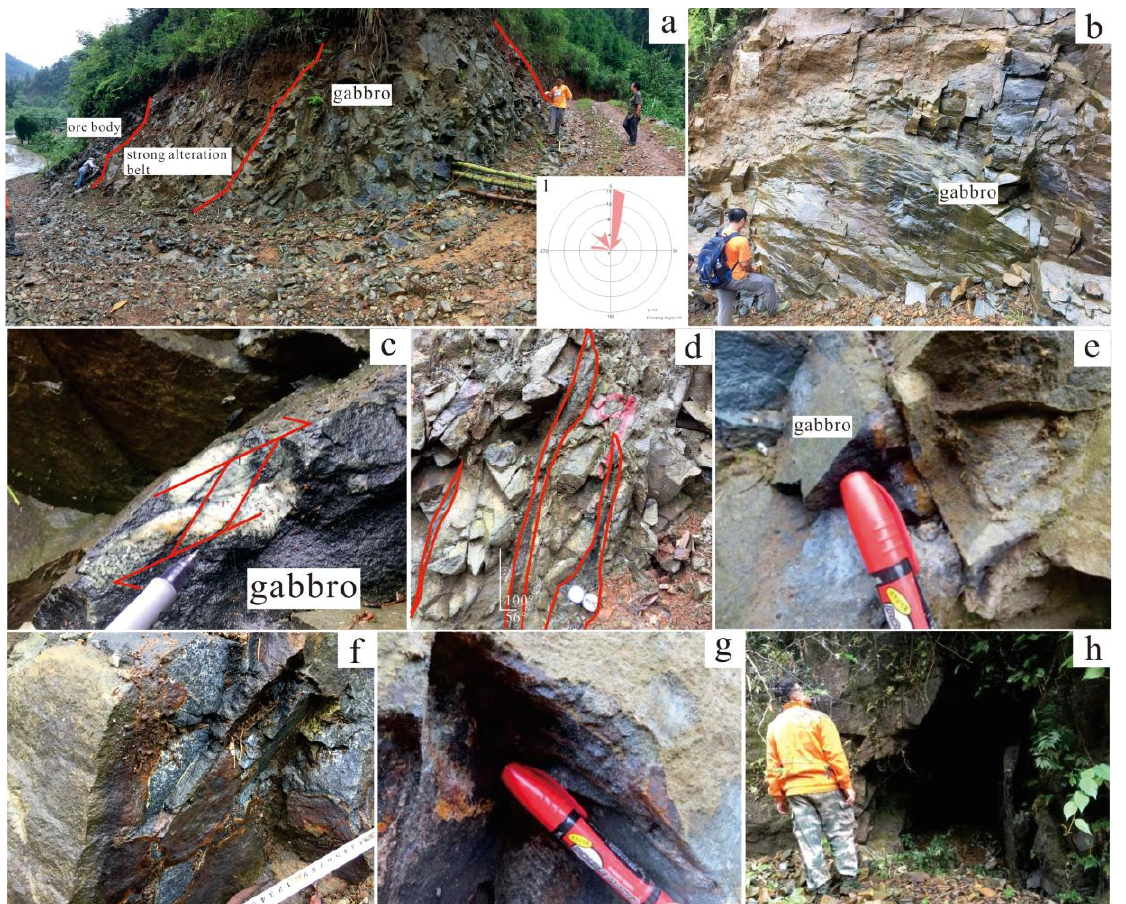
Figure 2. Representative outcrop photographs of the Ping’an Pb–Zn–Cu deposit in the northern Guangxi Province. ( a ) Field photograph of gabbro exposure and joint statistics rose diagram; ( b ) field-altered gabbro; ( c ) field photographs of gabbro subjected to brittle–ductile deformation (left-lateral shear); ( d ) traces of hydrothermal entry into the formation; ( e – g ) metasomatic alteration mineralization along the fissure; ( h ) mining hole.